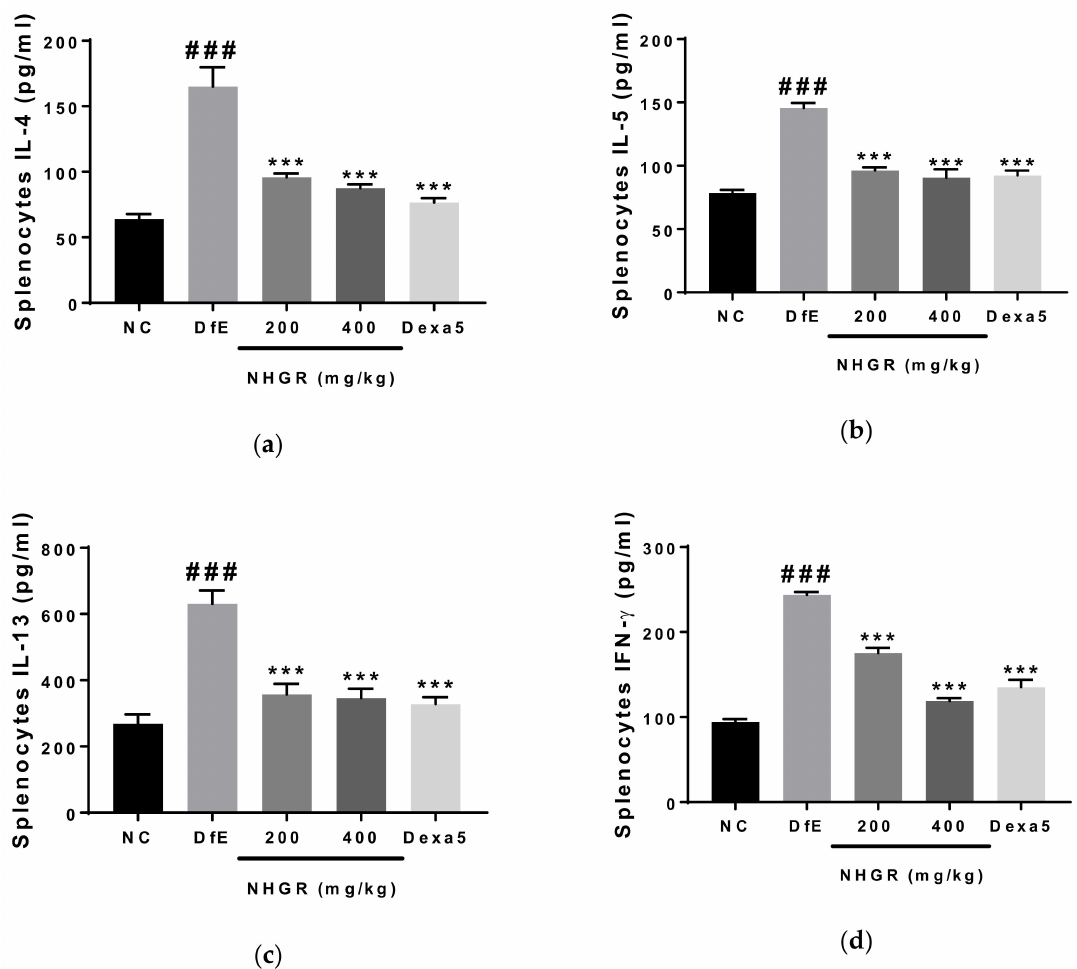
Figure 4. The e ff ects of Siraitia grosvenorii residual extract (NHGR) on the secretion of Th1 and Th2 cytokines by cultured splenocytes. The concentrations of ( a ) IL-4, ( b ) IL-5, ( c ) IL-13, and ( d ) IFN- γ in the cell culture supernatant were determined. The cells were maintained for 48 h at a density of 1 × 10 5 cells / well in 96-well plates using anti-CD3 antibody-coating. Data is showed as the means ± SEM ( n = 7). ### p < 0.001 compared with NC; *** p < 0.001 compared with Dermatophagoides farinae extract (DfE)-treated atopic dermatitis